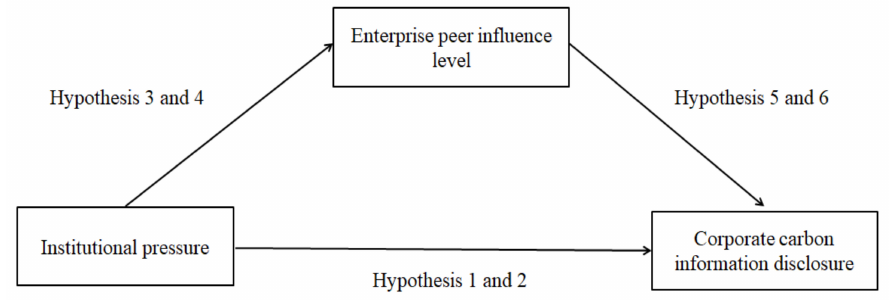
Figure 1. Relationship among institutional pressure, enterprise peer influence, and corporate carbon information